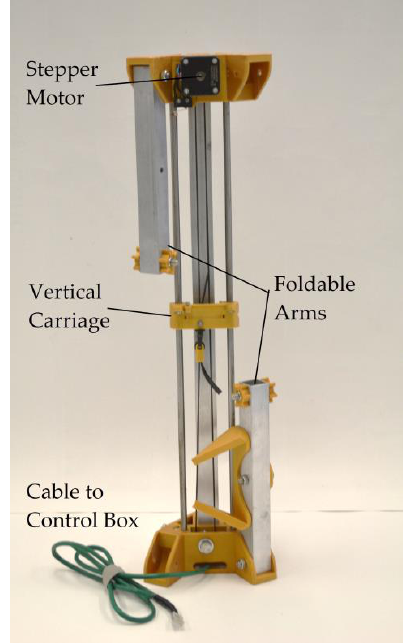
Figure 6. The motor module of the Kijenzi 3-D printer with key components labeled.